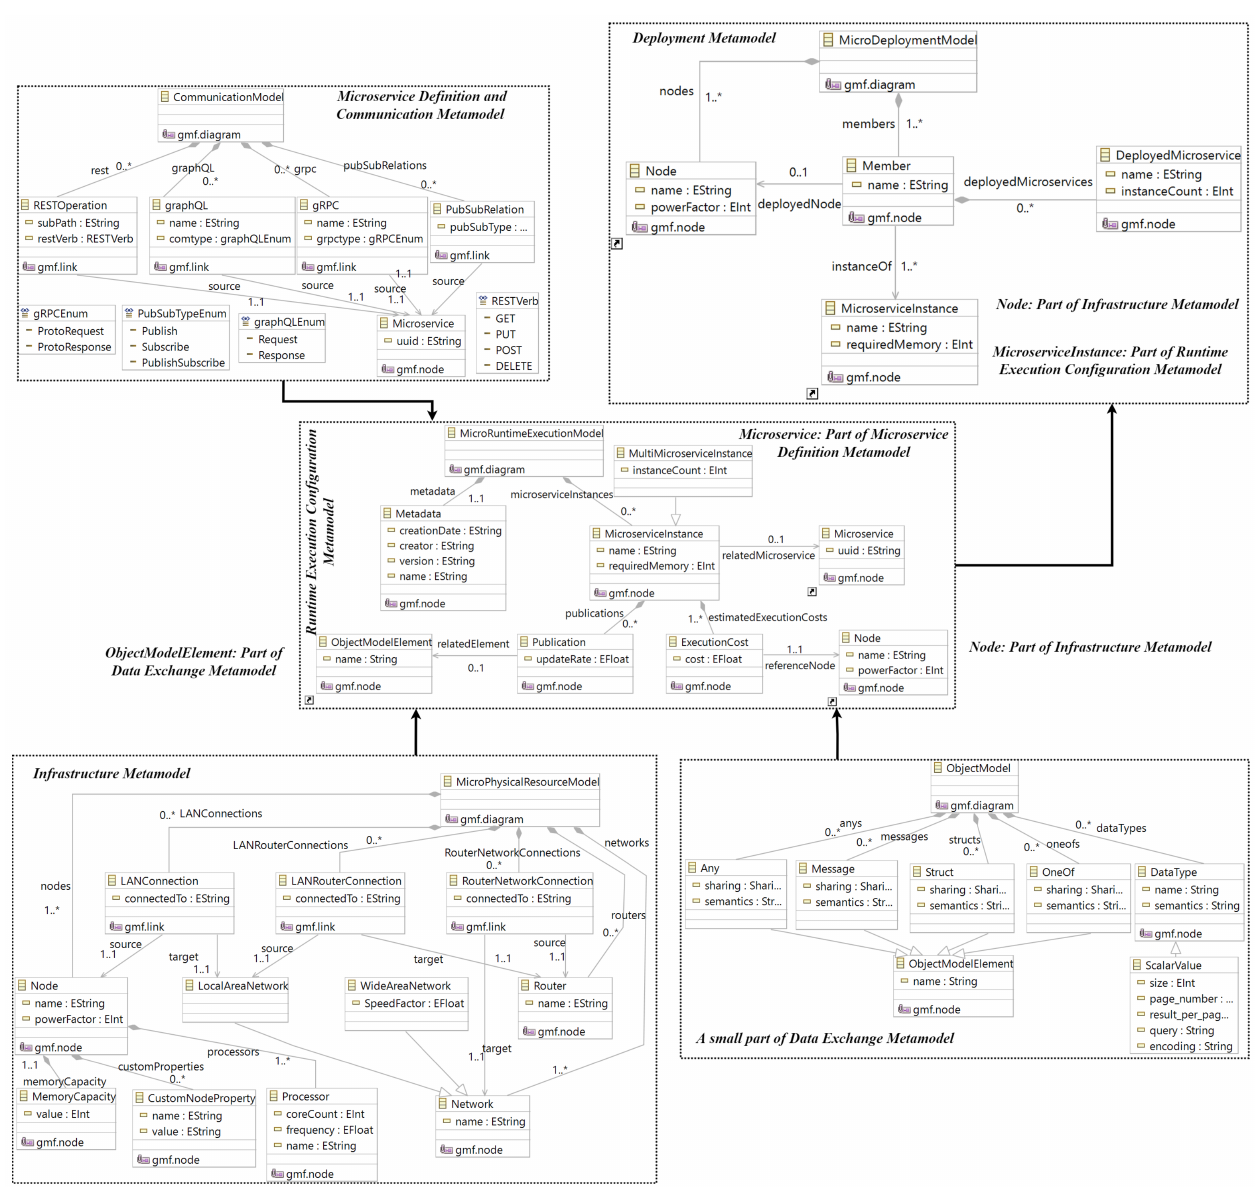
Figure A1. The overall model-driven architecture for deploying